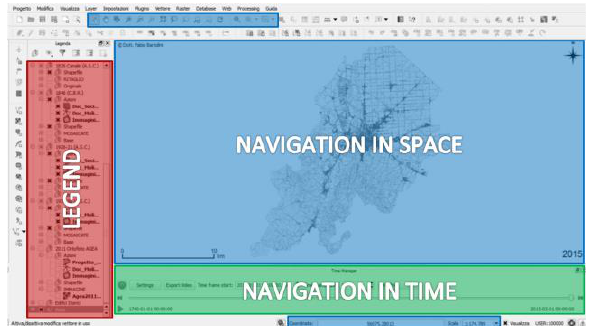
Figure 14. A screenshot of the HGIS; the legend and the areas for the navigation in space and time are highlighted in different